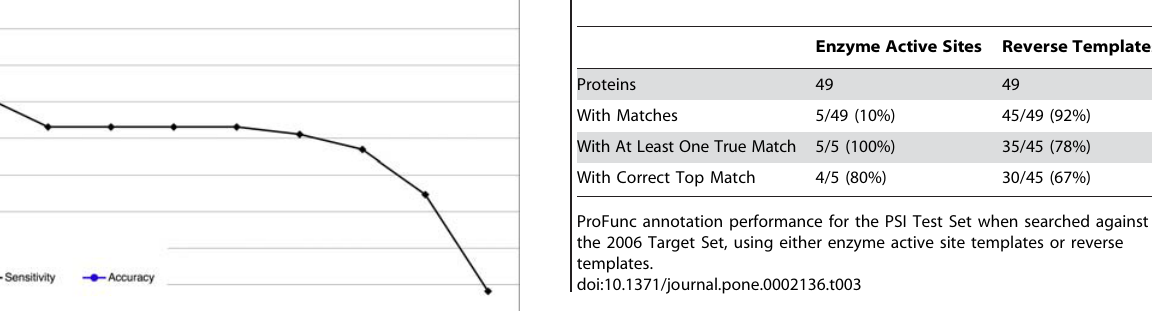
Table 3. ProFunc Template Annotation of PSI Test